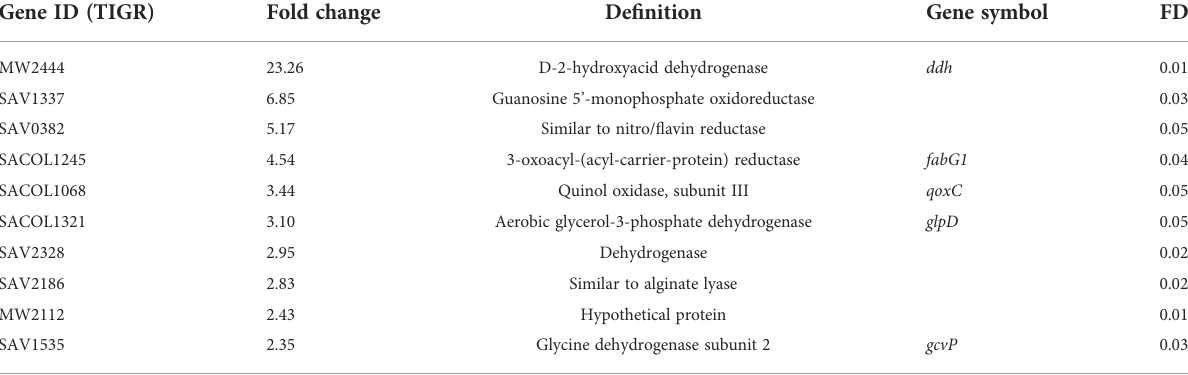
TABLE 6 Genes identi fi ed in the oxidoreductase category